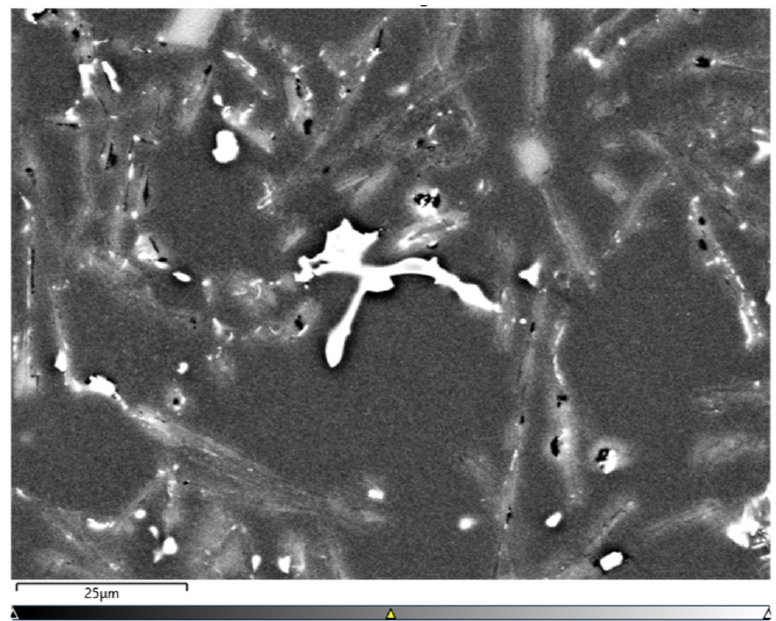
Figure 14. Microstructure of AlSi10Sn1.7 alloy with Sn addition (electron image).